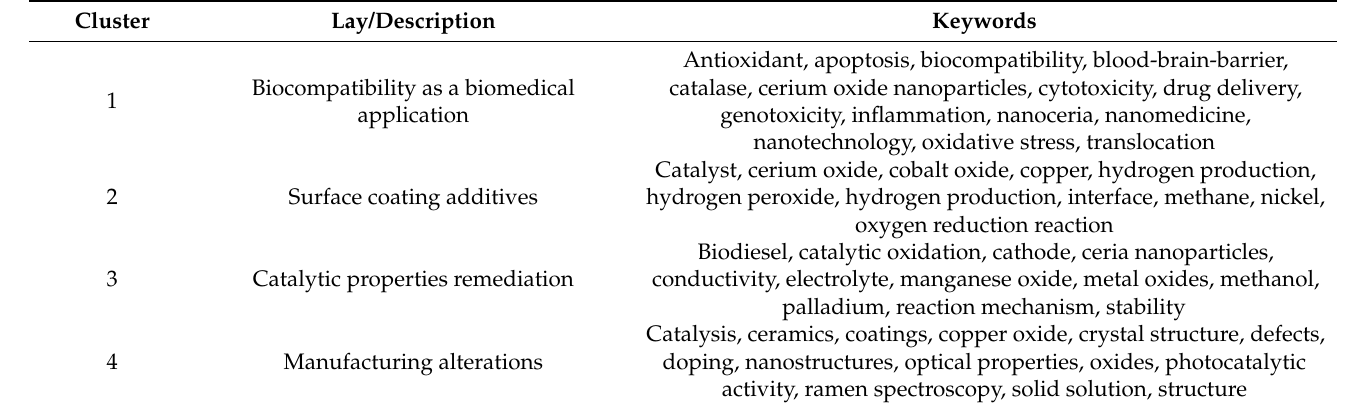
Table 3. Summary of the word clusters identified using VOSviewer and WoS dataset using the search term “cerium oxide OR ceria OR nanoceria OR nano ceria”. The network analysis from 7862 publications from 1990 to 2020. The clusters are also represented in a visualisation map (Figure